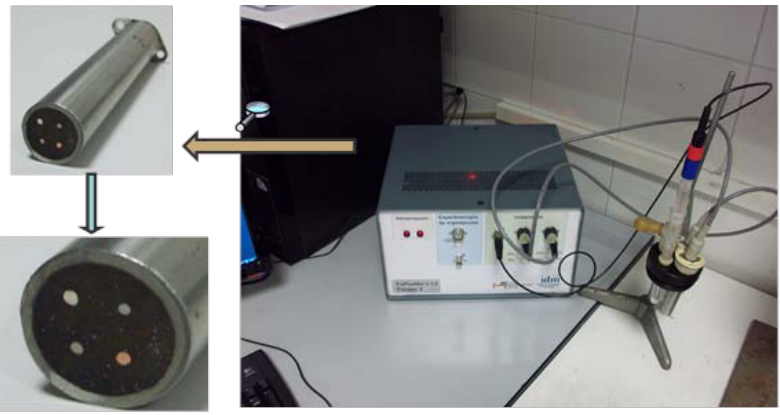
Figure 1. The electronic tongue formed by non-noble